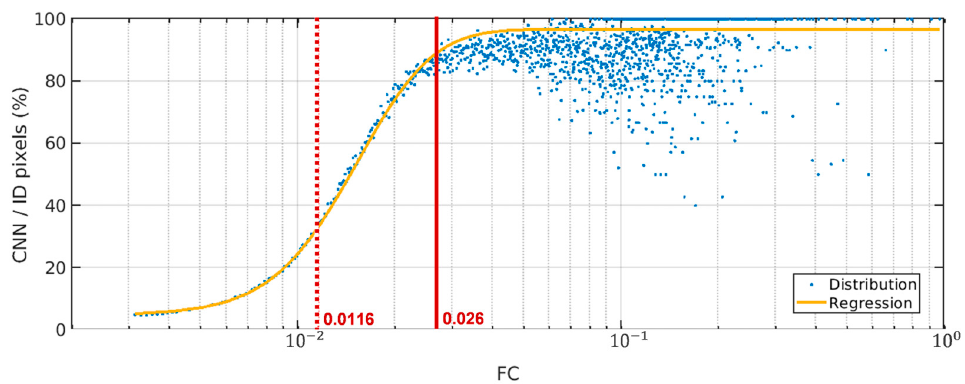
Figure 8. Proportion of MSI detections common to CNN and ID methods on the total IDs (in %) as a function of FC intervals (blue dots), each interval has a bin width of 2.79 × 10 − 4 . Intervals with less than 10 values are not represented. A Gompertz equation (Equation (9); yellow line) fits the blue points distribution and predicts the CNN detections accuracy. The red plain line represents the FC threshold from at least the CNN detects 90% of the IDs, and the red dotted line is the FC threshold used in Figure 6a.